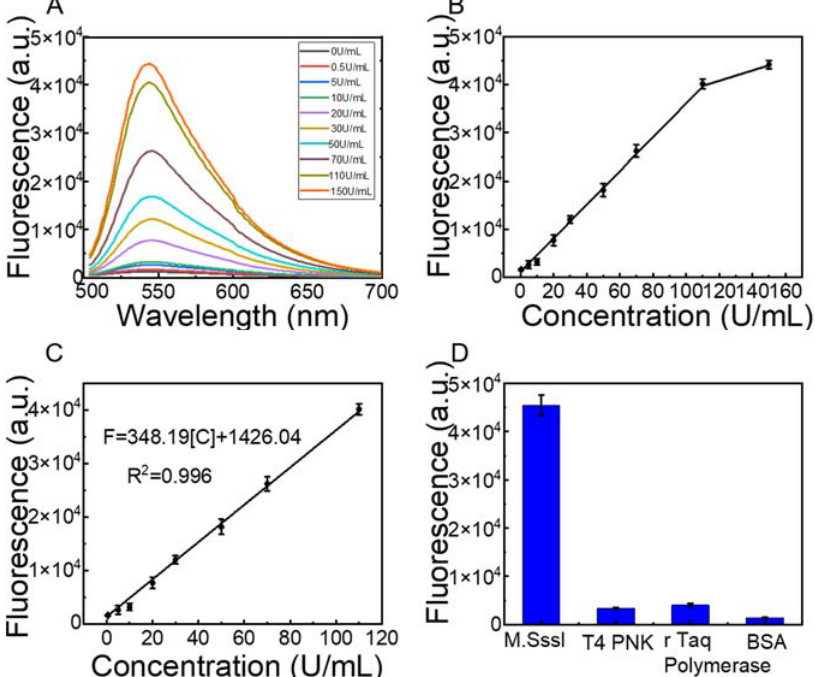
Figure 2. Sensitive and selectivity detection of MTase. ( A ) Fluorescence intensities after adding various concentrations of M.SssI; ( B ) relationship between the fluorescence intensity and concentra- tions of M.SssI; ( C ) correlation between the fluorescence intensity and MTase concentration in the range of 0.5 to 110 U/mL; ( D ) selectivity of the strategy. The reaction was formed via the addition of